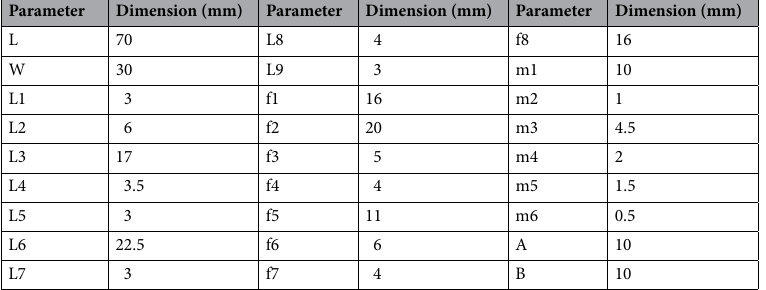
Parameter Dimension (mm) Parameter Dimension (mm) Parameter Dimension